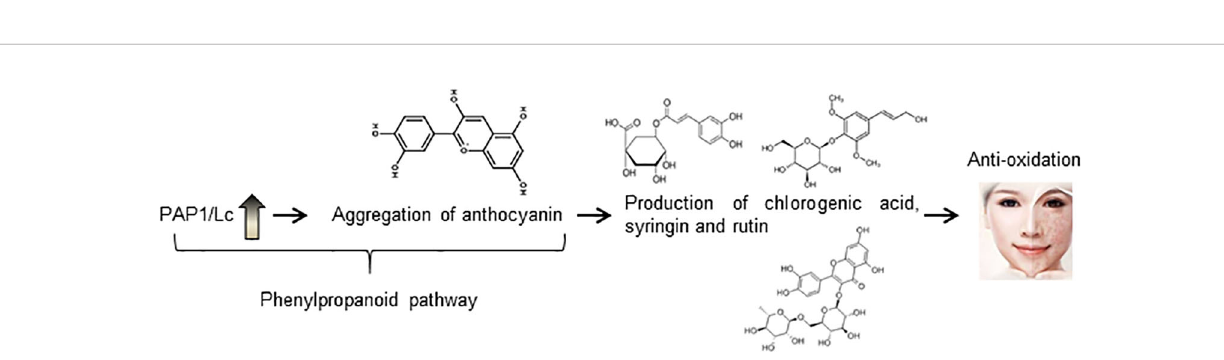
FIGURE 4 | Flow chart of secondary metabolites. The employment of 3GT was used in S. involucrata to catalyze the formation of primary glycosylatory metabolites.